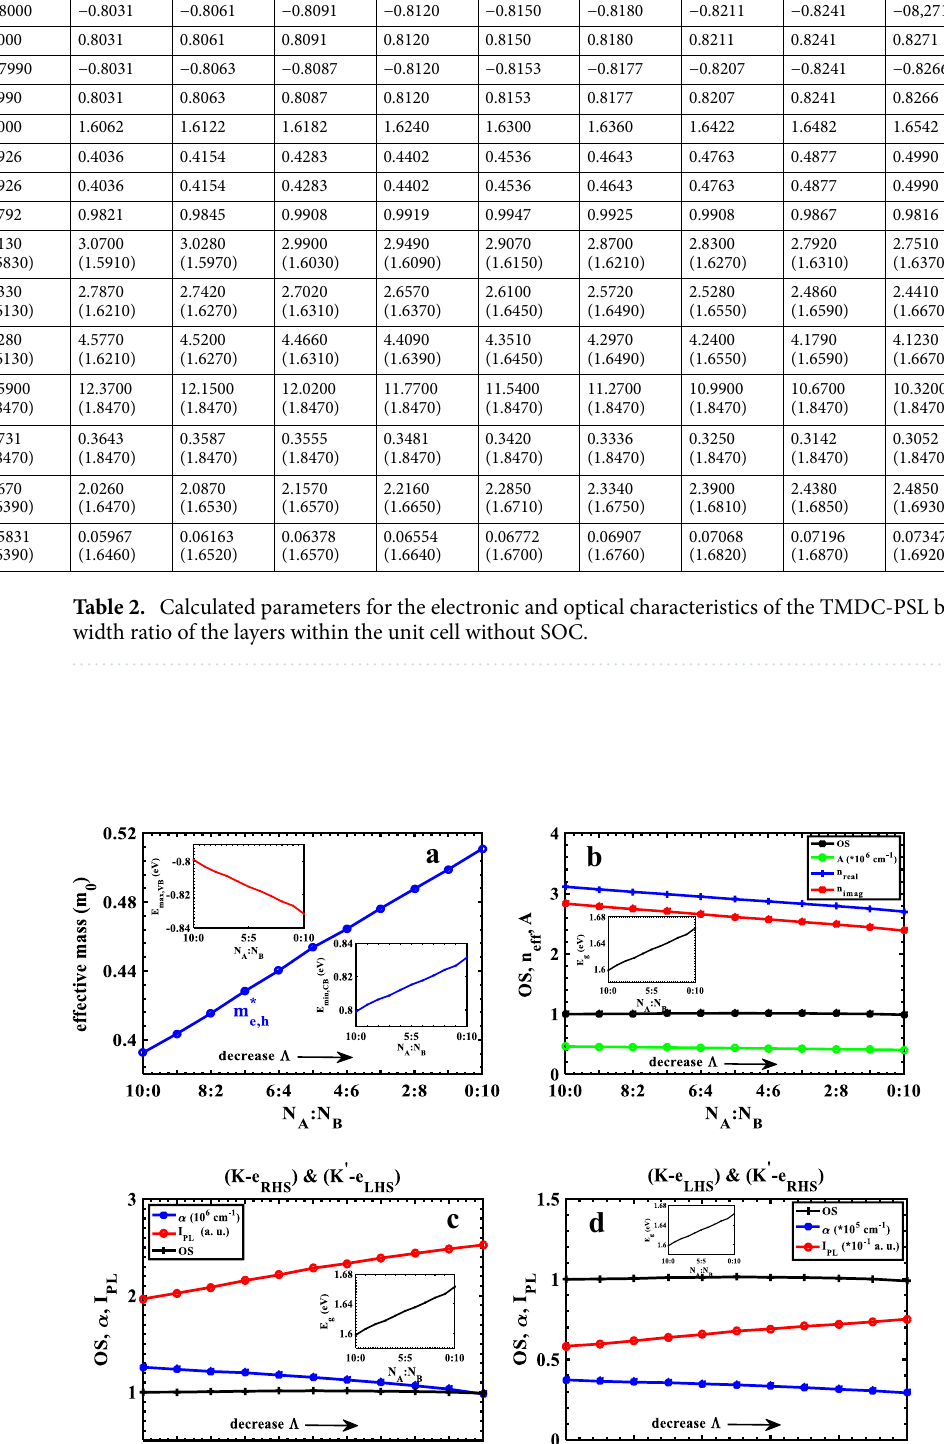
Figure 7. Electronic and optical characteristics of the TMDC-PSL based on the width ratio of the layers without SOC; ( a ) effective mass; ( b ) real (blue) and imaginary (red) effective refractive index, absorbance (green), and OS (black); Absorption coefficient and photoluminescence at K (cid:31) K ′ (cid:30) spin for incident light polarizations of ( c )